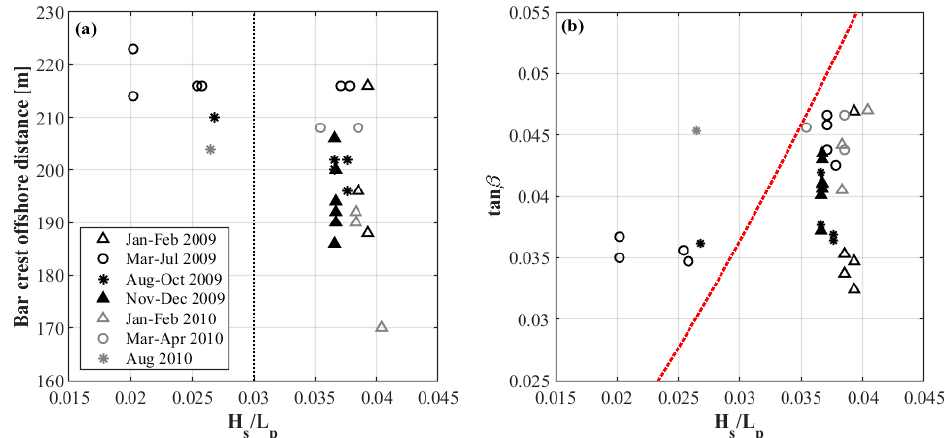
Figure 5. Dependence of steepness Hs/Lp of transformed monthly Q99 waves (depth 4.4 m) for 2009–2010 on ( a ) the offshore distances of the outer bar crest, black dashed line—wave steepness threshold, and ( b ) the mean slope tan β , red dashed line—criterion for identification of non-linear wave transformation scenarios [tan β = 7(Hs/Lp) 3/2 ]; black symbols—2009 values, grey symbols— 2010; circles—seaward bar crest positions, triangles—shoreward bar crest locations, stars—bar crest displacements.